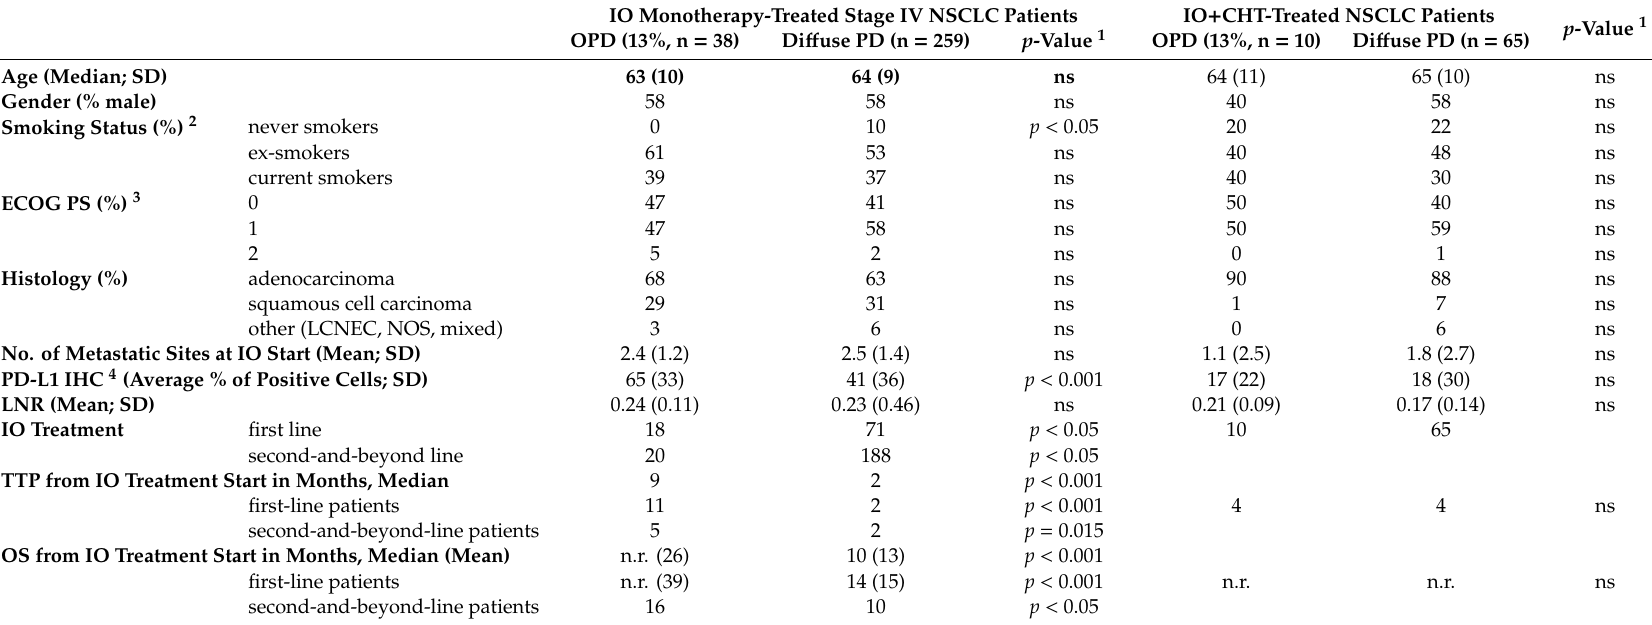
Table 1. Characteristics of patients with disease progression in this